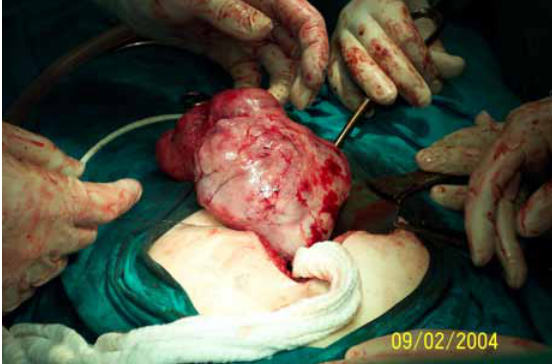
Figure 3. Retroperitoneal tumor was dissected from surrounding structures and removed